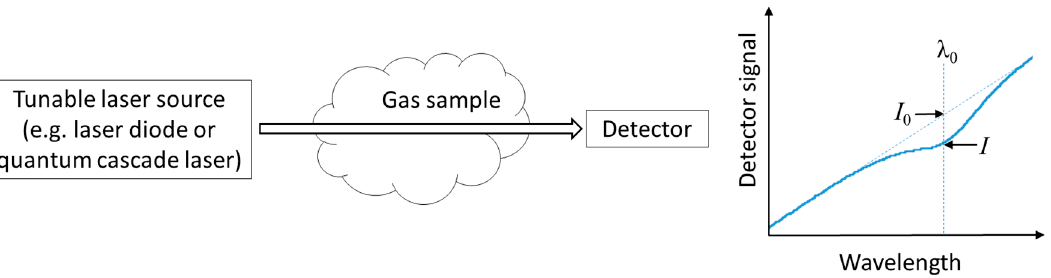
Figure 1. Schematic diagram of laser-based gas sensing.